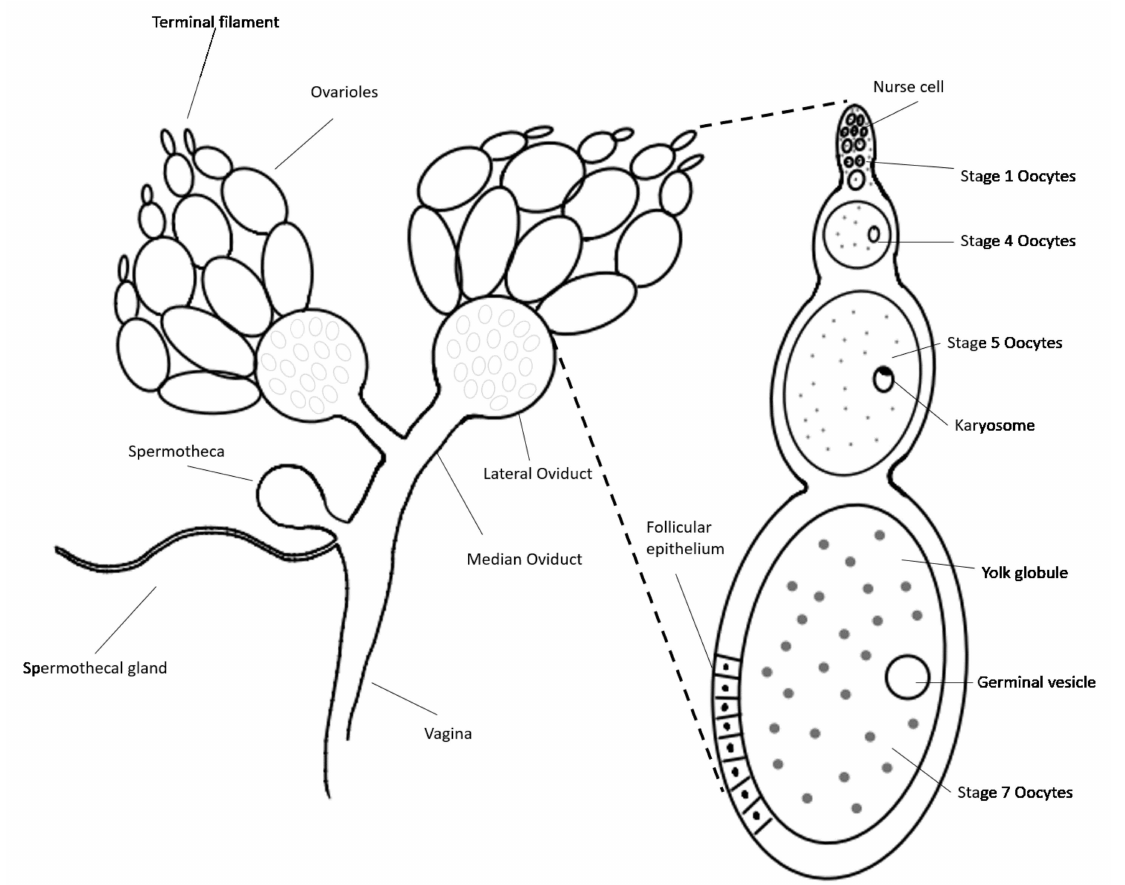
Figure 3. Schematic diagram of ovary structure and oogenesis in the female adult mealworm. The ovary consists of ovarioles, i.e., the basic unit of egg production. The yolk globule is inside the ovarioles, and the follicular epithelium surrounds them on the outside. Small ovarioles gradually develop and become mature follicles; eggs eventually ovulate from the mature